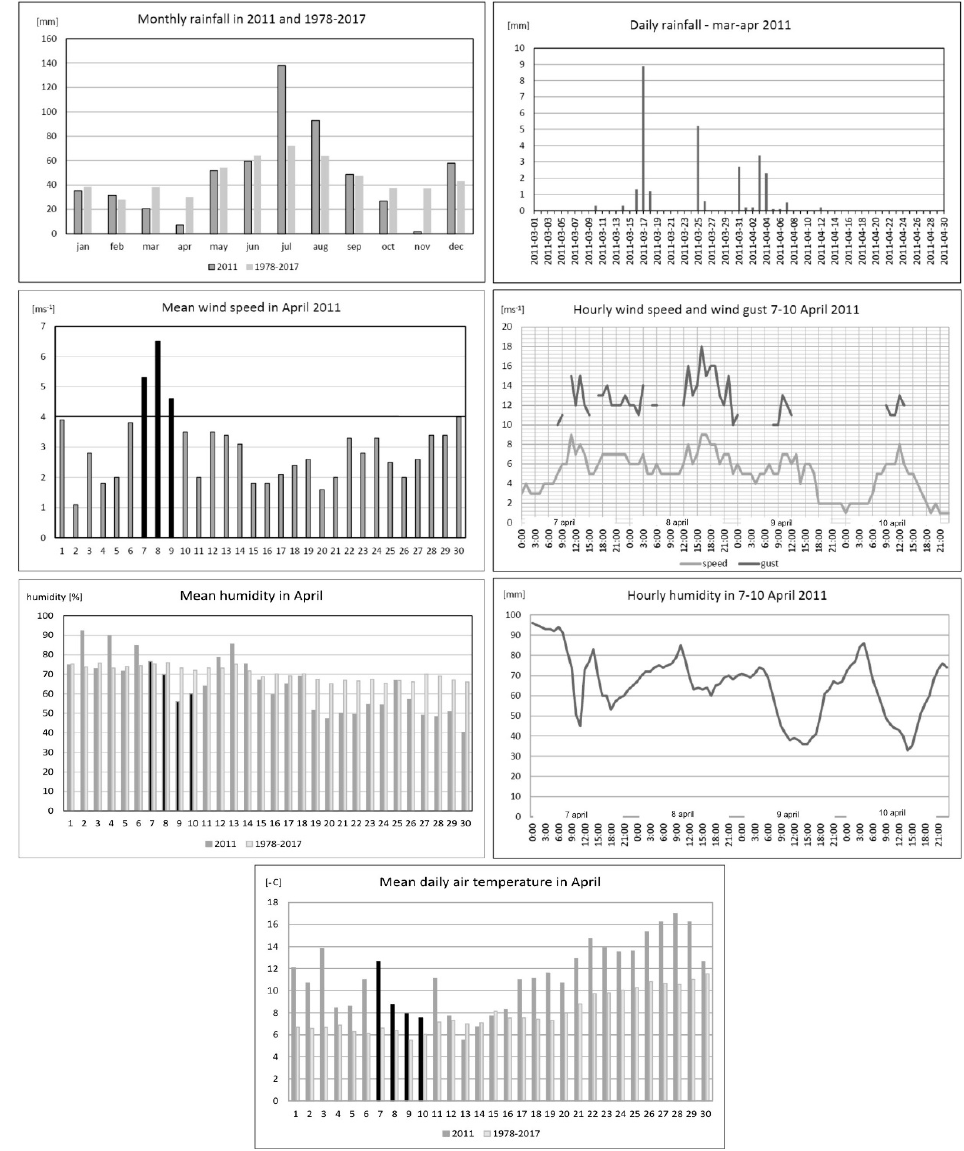
Figure 3. Meteorological conditions in days with extreme aeolian processes and over a long period (1978–2017) for IMWM Piła station.